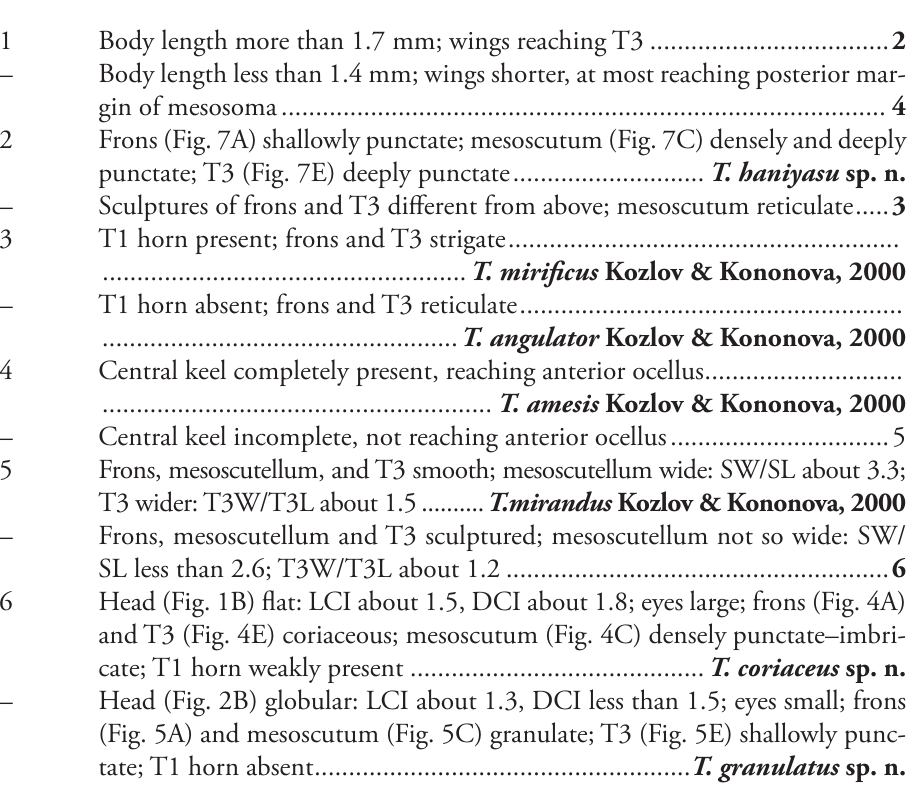
Key to species of brachypterous female of the Eastern Palearctic Trimorus (“Brachypterous” means shortened wing reaching or not beyond posterior margin of T3 in this key.)